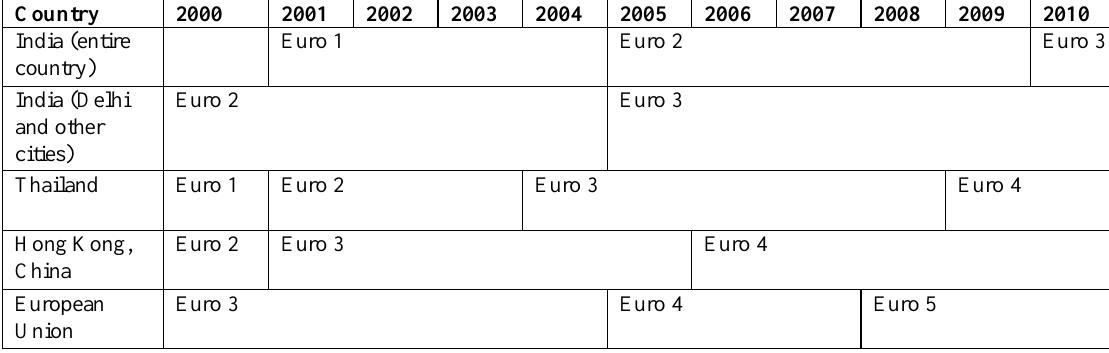
Table 11. Emission standards for new vehicles (light duty) in selected countries